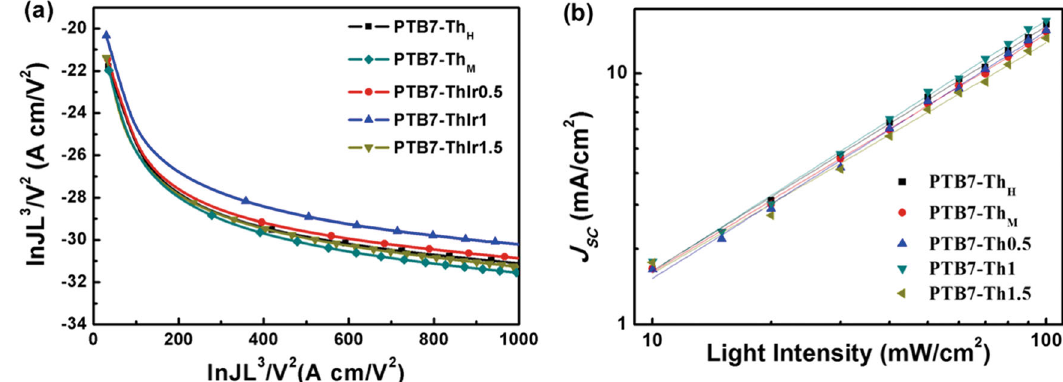
Fig. 4 a J – V curves for hole-only devices based on PTB7-ThIrx/PC 71 BM blended fi lm and b light intensity dependence of J